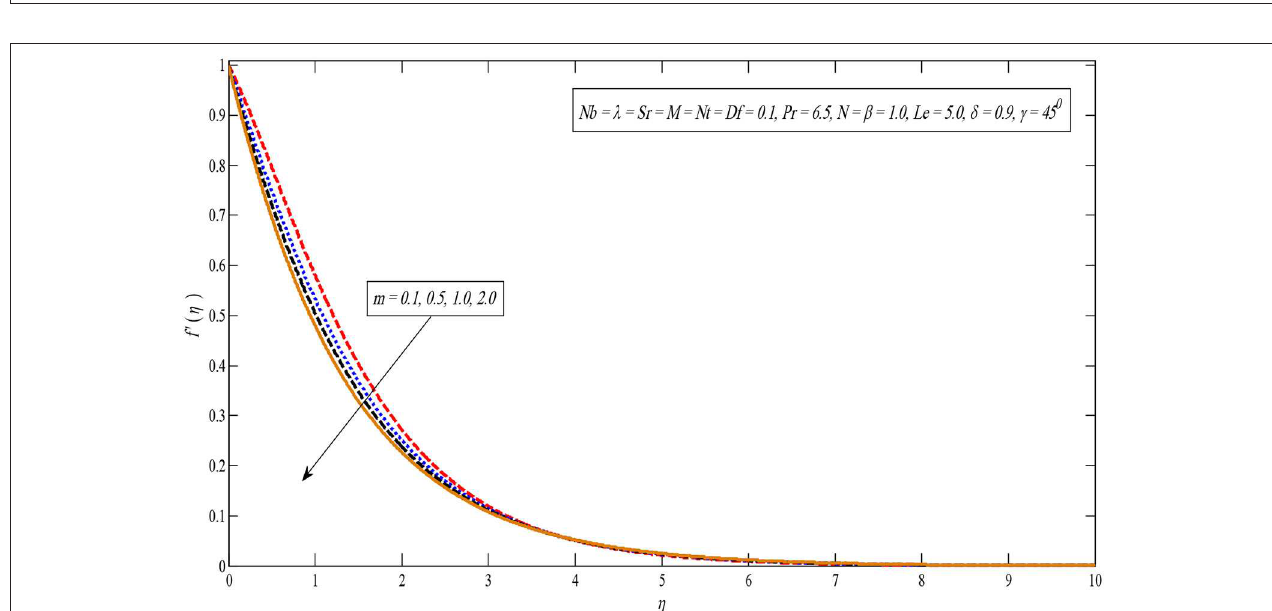
FIGURE 3 | Velocity profile for several values of m